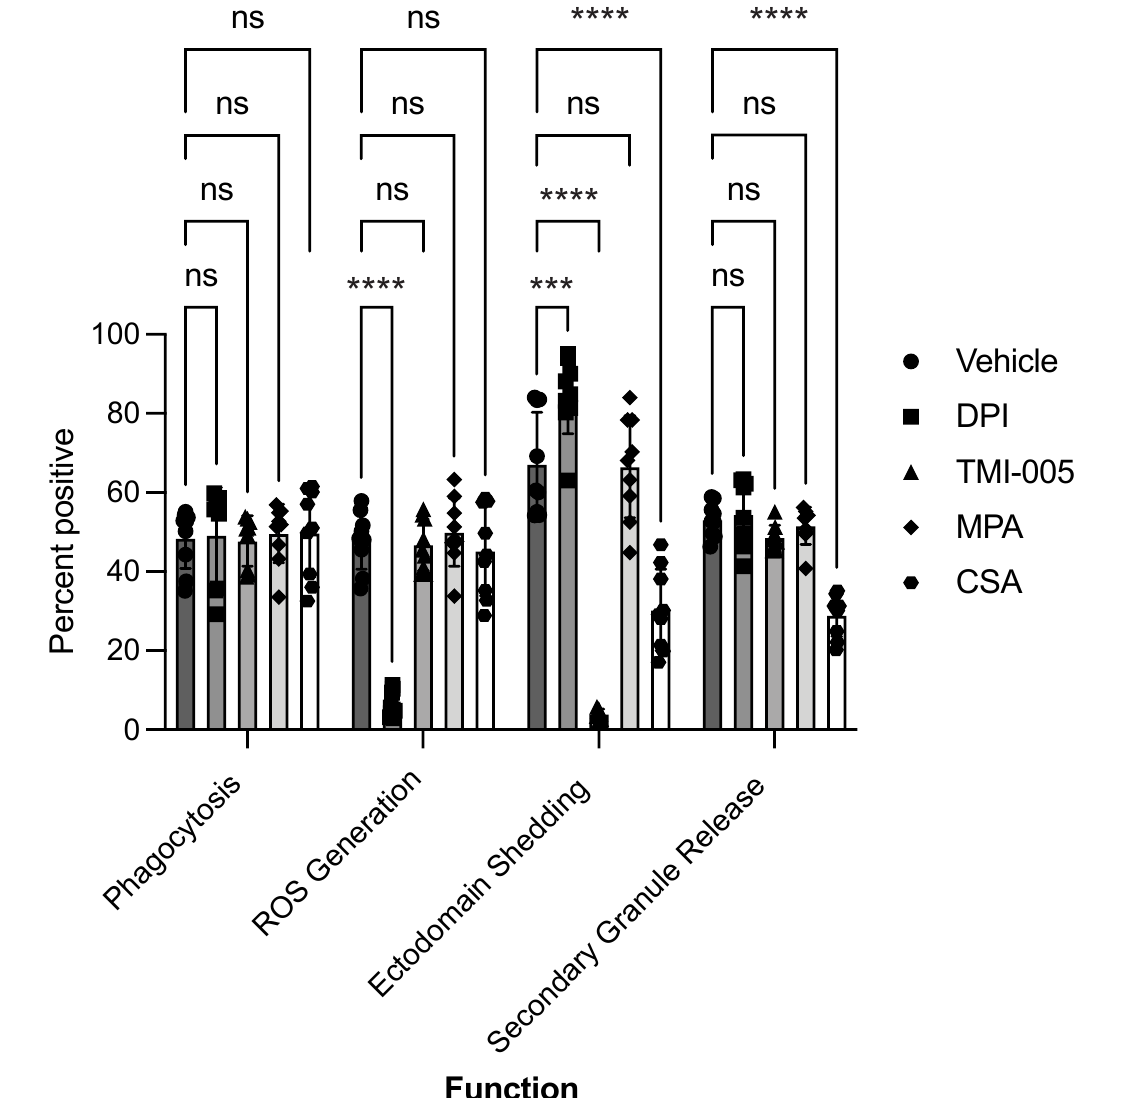
Figure 5. The multiparametric assay screens for modulation of neutrophil function by therapeu- tic and inhibitory drugs. Neutrophils were pre-treated with functional inhibitors TMI-005 or diphenyleneiodonium (DPI) or the immunosuppressive drugs cyclosporine A (CSA) or mycopheno- late (MPA) for one hour. Neutrophils were then co-cultured with C. albicans (MOI of 3) for 30 min. The frequency of total neutrophils performing phagocytosis, ROS generation, ectodomain shedding, or secondary degranulation was measured. Data are represented as mean ± SD; n = 3 per group in each experiment per donor; experiments were repeated three times with three different donors.